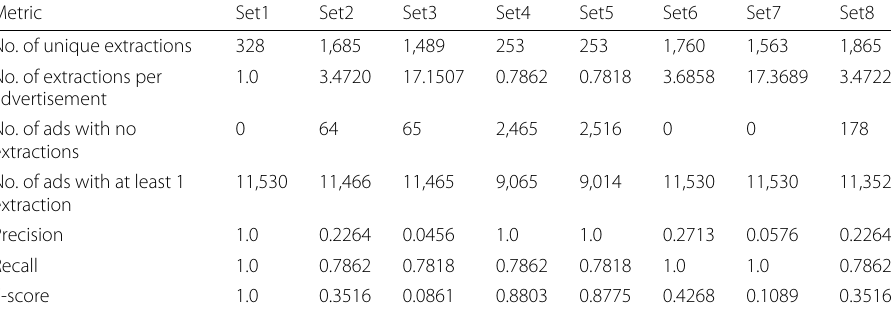
Table 3 Dataset characteristics for city extractions